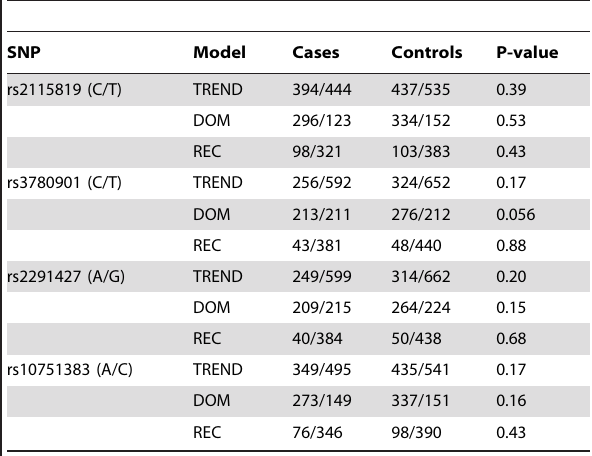
Table 4. Associations between the ALOX5 gene and CD in Canadian children.